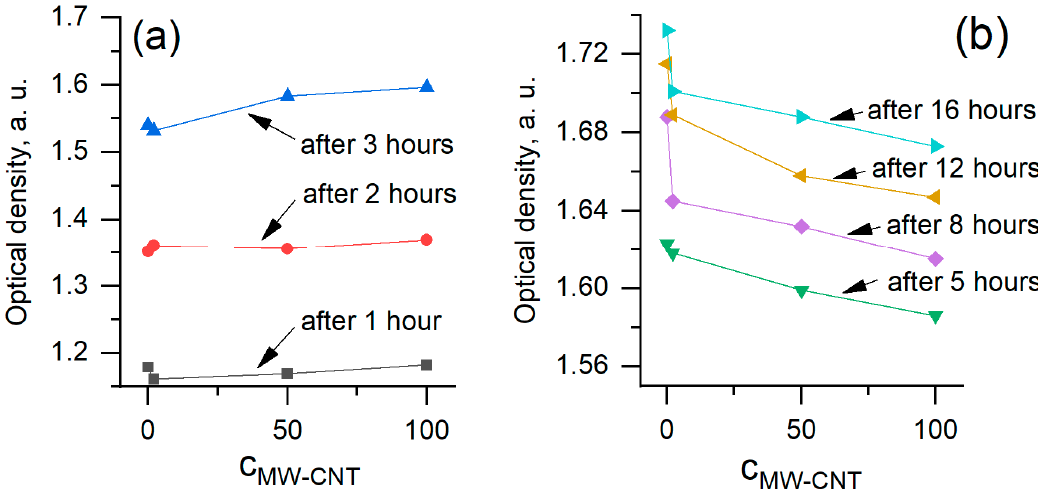
Figure 7. Dependence of optical density on MW-CNTs concentration at a different time: ( a ) 1–3 h; ( b ) 5–16 h.